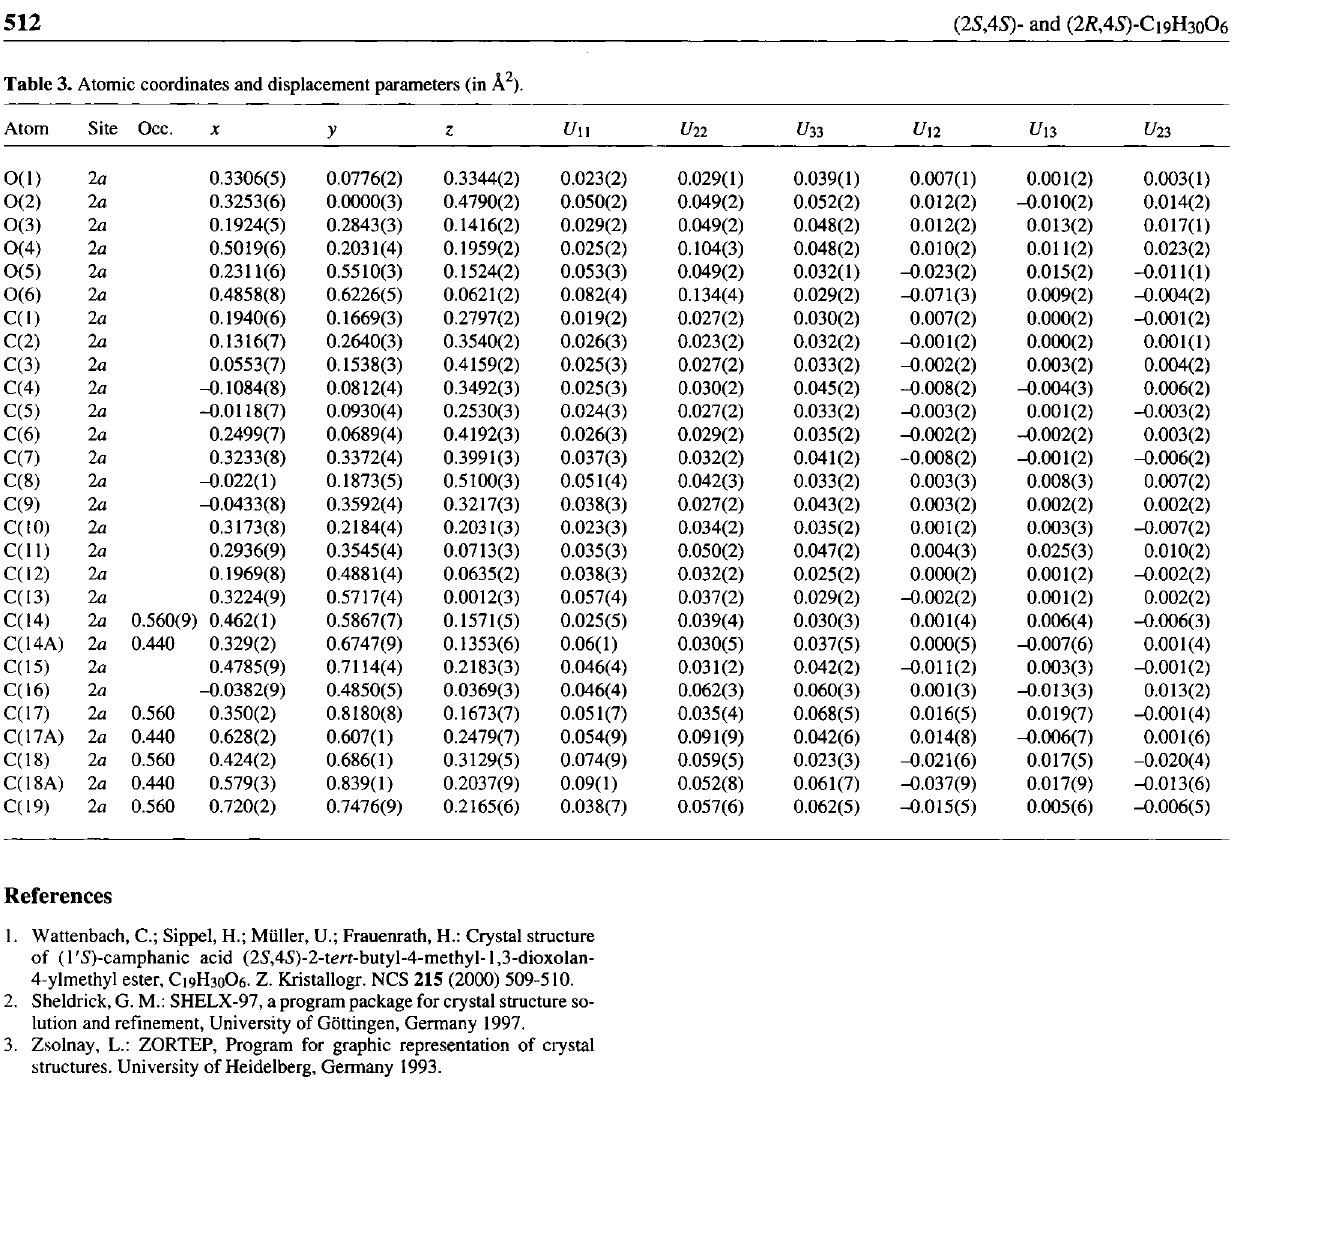
Table 3. Atomic coordinates and displacement parameters (in Â 2 ). Atom Site